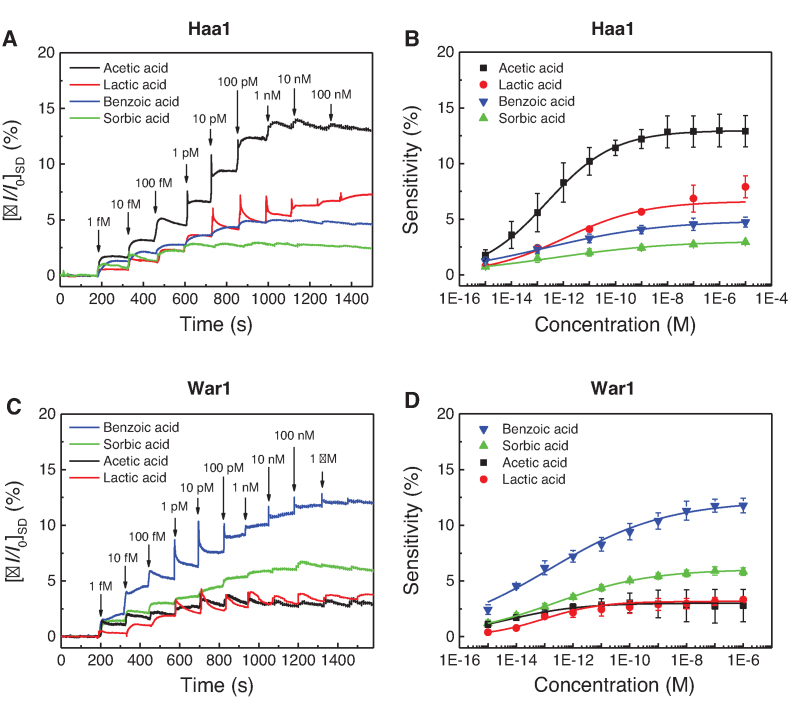
Direct binding of various weak acids to Haa1 and War1. (A) Real-time response of the Haa1-functionalized CNF-FET biosensor to various concentrations of acetic, lactic, sorbic and benzoic acids (1 fM to 100 nM). (B) Concentration-dependent responses to acetic, lactic, sorbic and benzoic acids with normalized sensitivity. Normalized sensitivity indicates the saturation level of \documentclass[12pt]{minimal}
\usepackage{amsmath}
\usepackage{wasysym}
\usepackage{amsfonts}
\usepackage{amssymb}
\usepackage{amsbsy}
\usepackage{upgreek}
\usepackage{mathrsfs}
\setlength{\oddsidemargin}{-69pt}
\begin{document}
}{}${[ {I/{I_0}} ]_{SD}} \times \ 100$\end{document} measured after exposure to the acid analytes. The real-time response measurement was repeated three times and the sensitivity is indicated as average ± SD. (C) Real-time response of the War1-functionalized CNF-FET biosensor to various concentrations of acetic, lactic, sorbic and benzoic acids (1 fM to 1 μM). (D) Concentration-dependent responses to acetic, lactic, sorbic and benzoic acids with normalized sensitivity. The real-time response measurement was repeated three times.